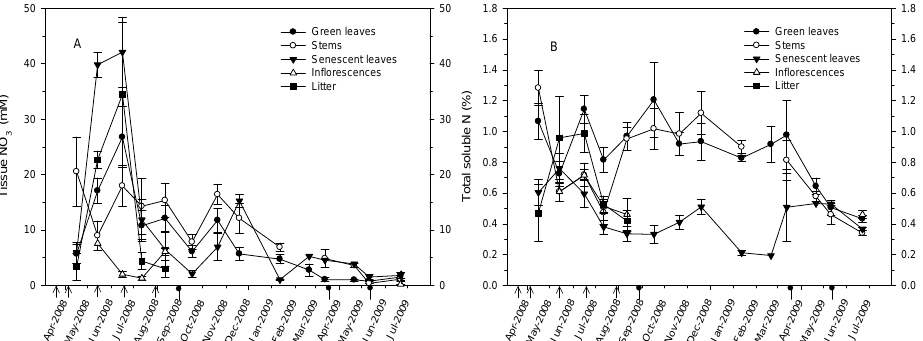
Fig. 6. Seasonal variations in bulk tissue NO 3- concentration (A) and total soluble N (B) per unit dry matter in different tissues of ryegrass. The bar with arrow represents N application as NH 4 NO 3 ; the bar with solid circle represents N application as urea .